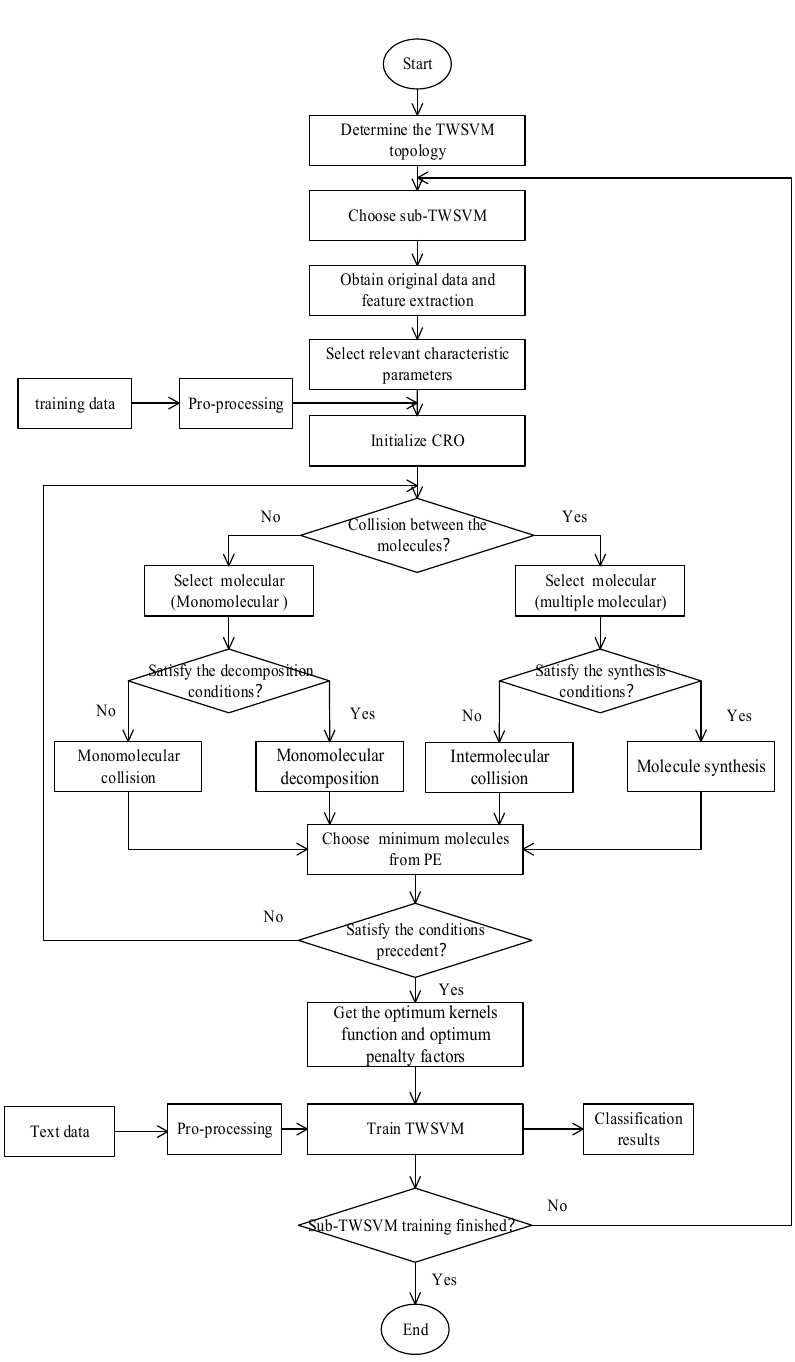
Figure 2. CRO-TWSVM design and training flowchart.